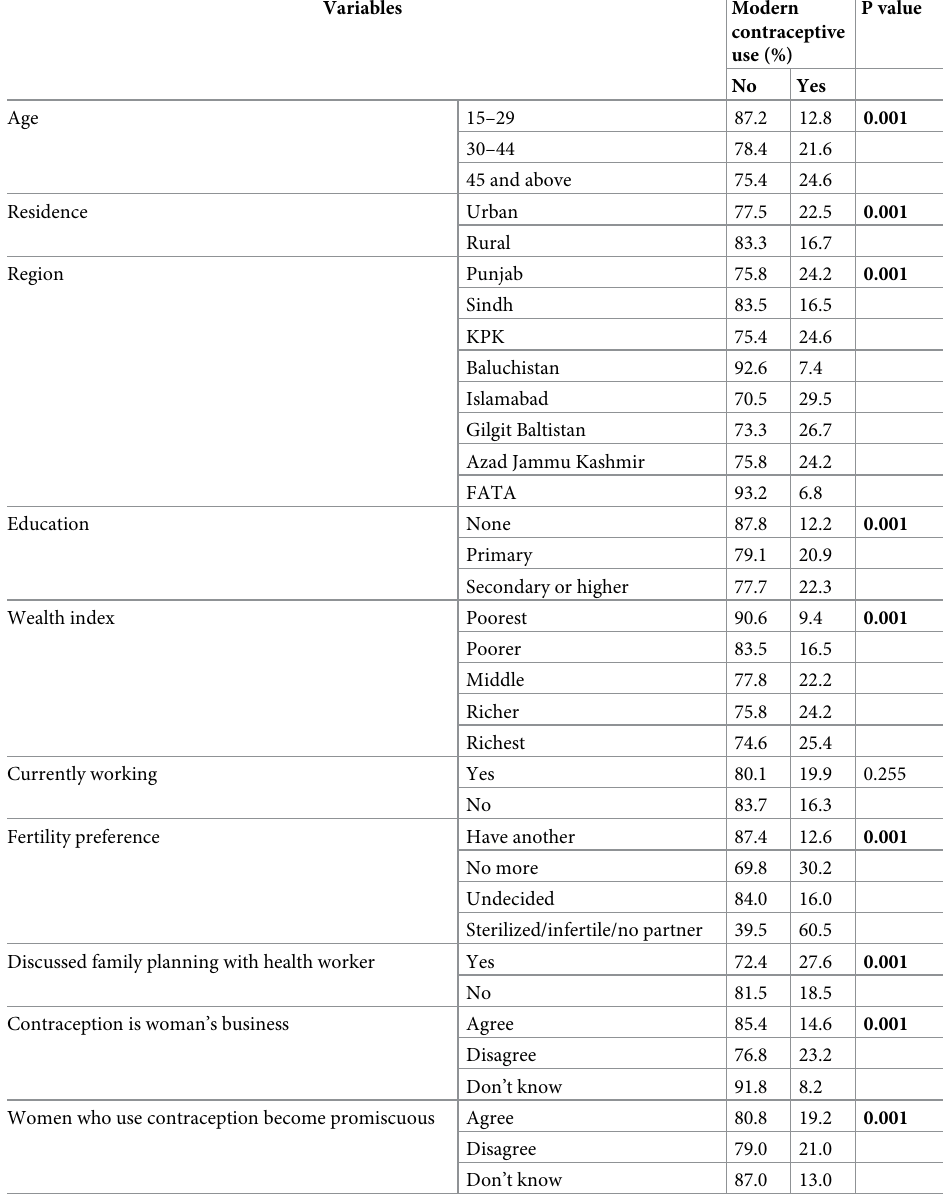
Table 2. Association of independent variables with modern contraceptive